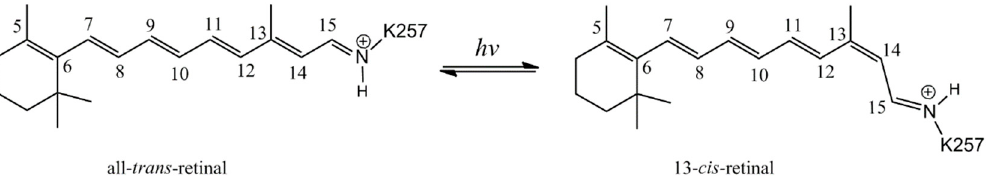
Figure 2. All-trans to 13-cis isomerization of the retinal chromophore in ChR2 .